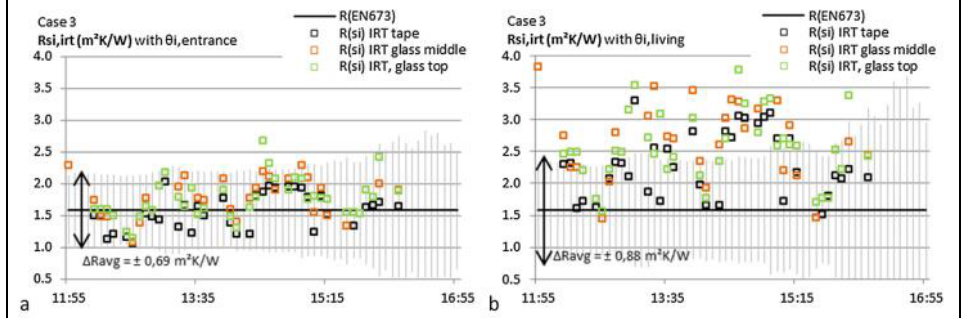
Figure 24. ( a ) Resistance Calculation for location 1 and ( b ) Resistance Calculation for location 2 for Case 3 Sample [34].